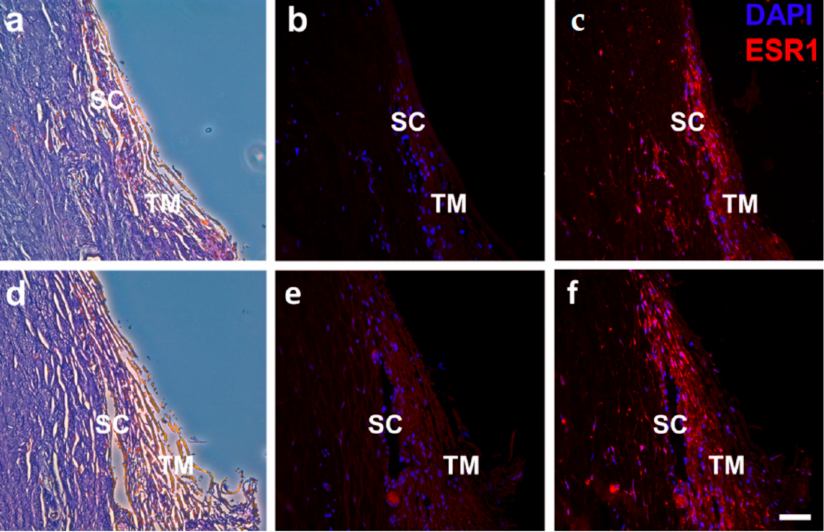
Figure 6. Expression of ESR1 in the trabecular meshwork (TM)/Sclemm’s canal (SC) region of human outflow tissue. ESR1 protein was expressed in the TM/SC region of human outflow tissue ( n = 4, 24–60 years of age) taken from both male ( a – c ) and female ( d – f ) post-mortem donors. Representative images of H&E ( a , d ), negative control ( b , e ), and positive staining ( c , f ). ESR1, estrogen receptor 1; TM, trabecular meshwork; SC, Schlemm’s canal. Scale bar: 50 µ